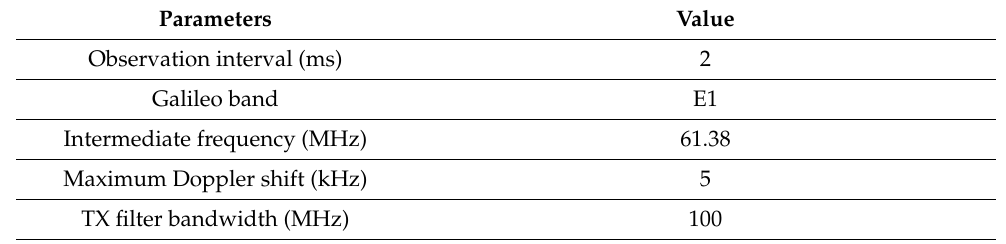
Table 2. Parameters in